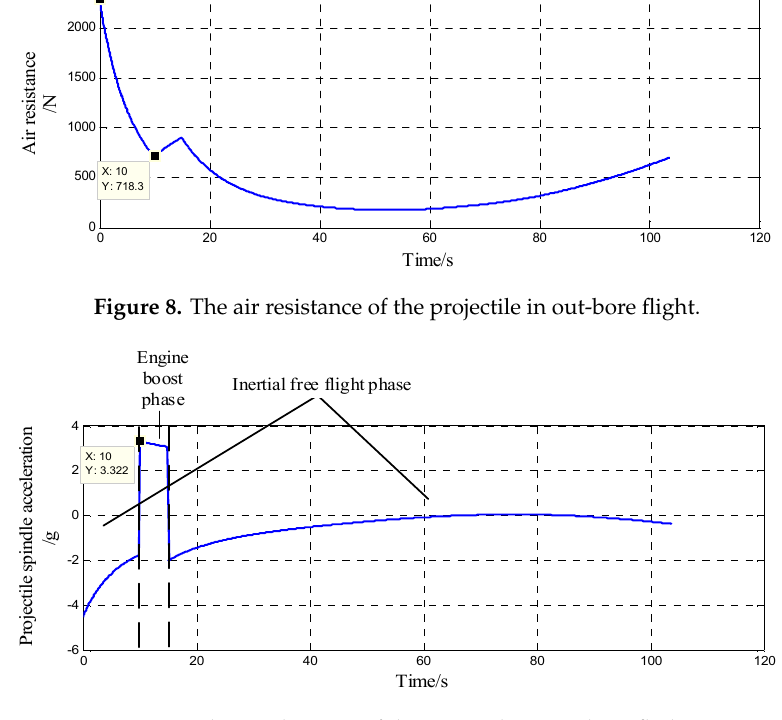
Figure 9. The acceleration of the projectile in out-bore flight.